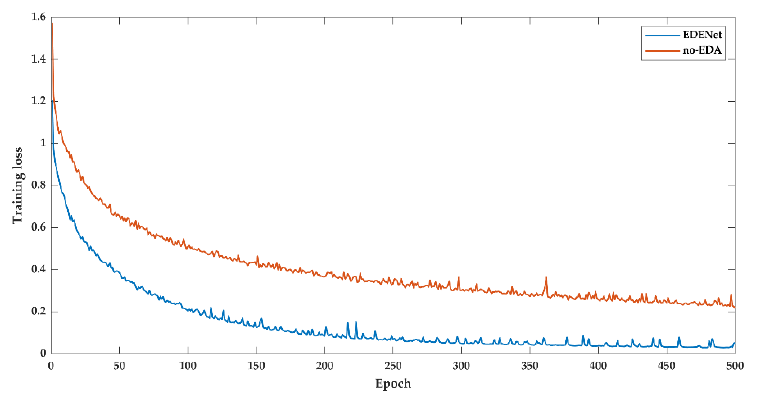
Figure A2. Training mIoU of Vaihingen dataset.